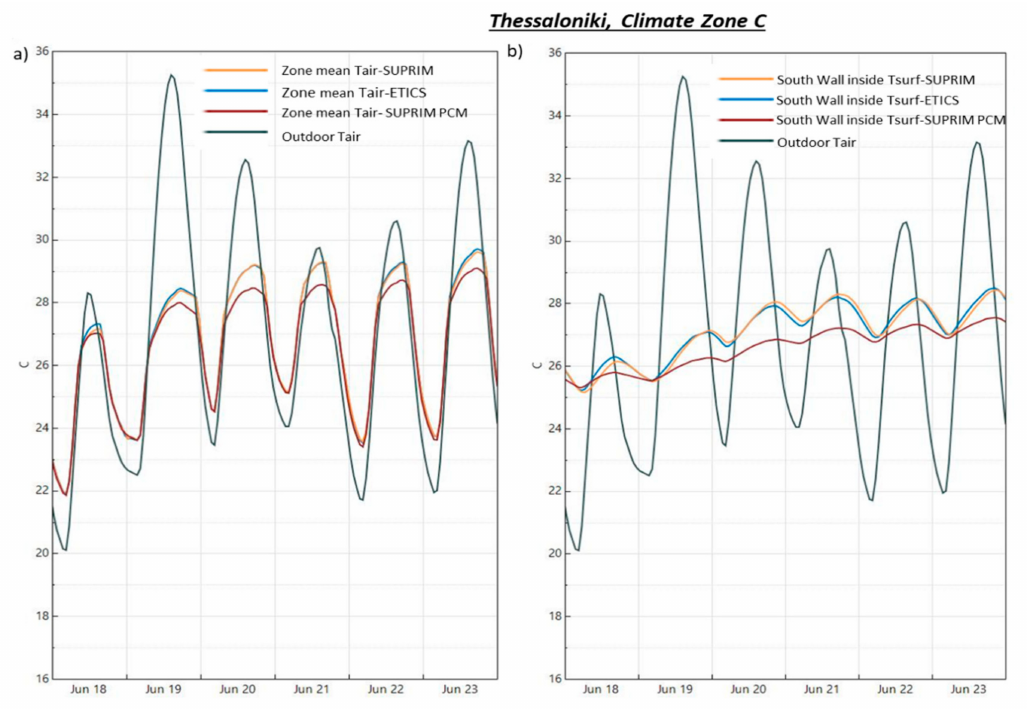
Figure 10. Climate zone C: ( a ) outdoor Tair and indoor Tair and ( b ) outdoor Tair and Tsurf evolution of the south facing wall during a typical week in June for the three investigated wall configurations and for 10 cm external insulation.